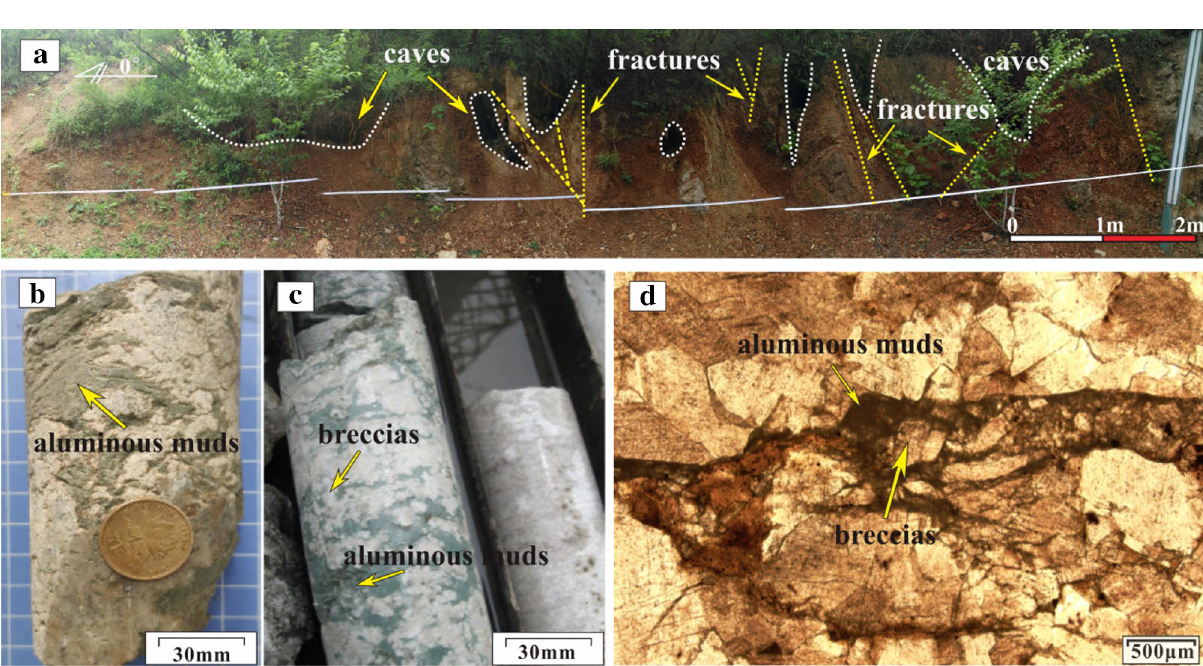
Figure 6. Photos of dissolution channels in outcrop areas: ( a ) Dissolution channels in the Ordovician Majiagou Formation in Bagong Mountain (see Fig. 1c); ( b ) Dissolution channels in the Ordovician Majiagou Formation in Bagong Mountain (see Fig. 1c).